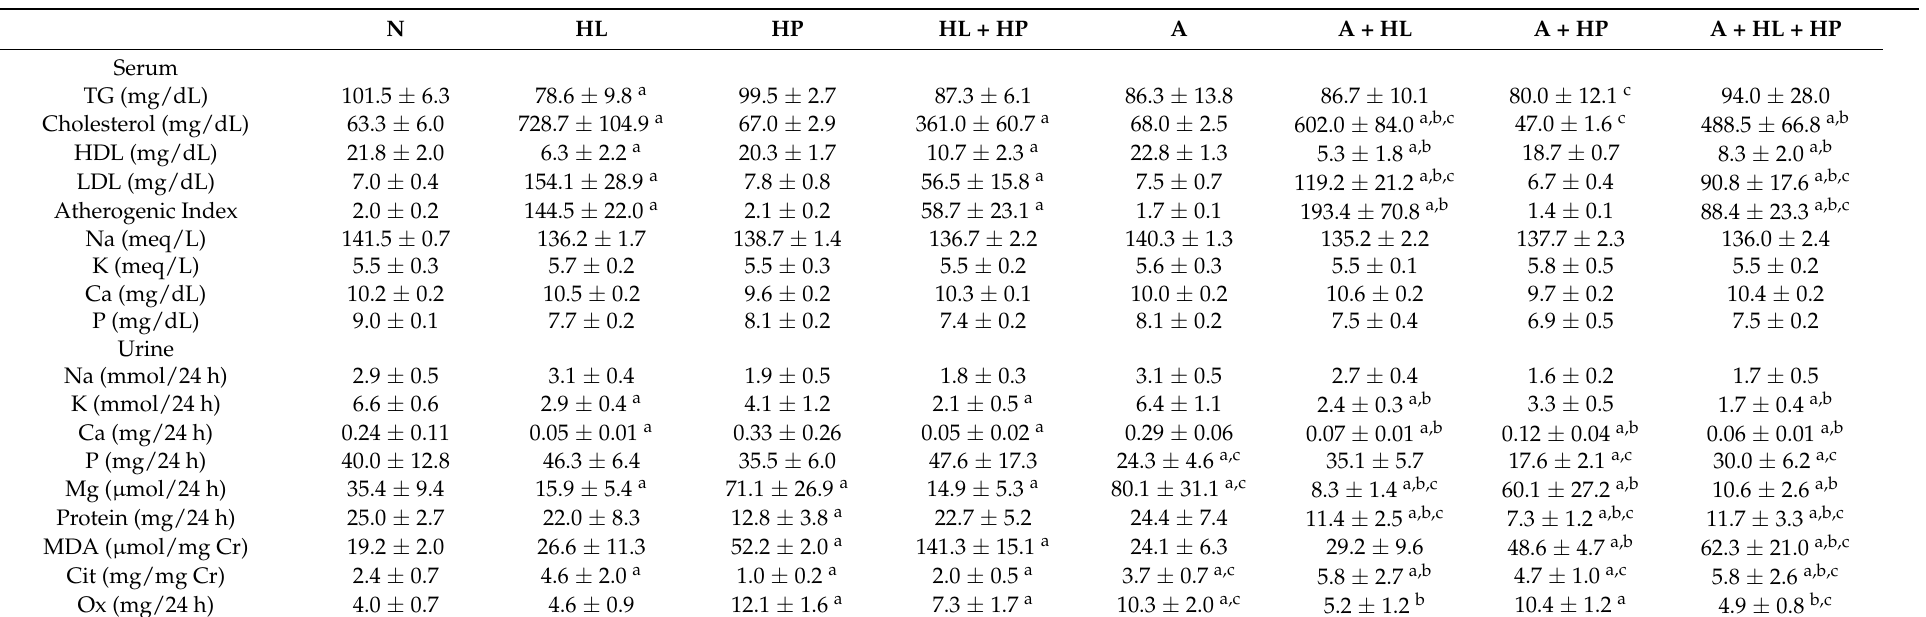
Table 2. Serum biochemistry and 24 h urinary profiles of each